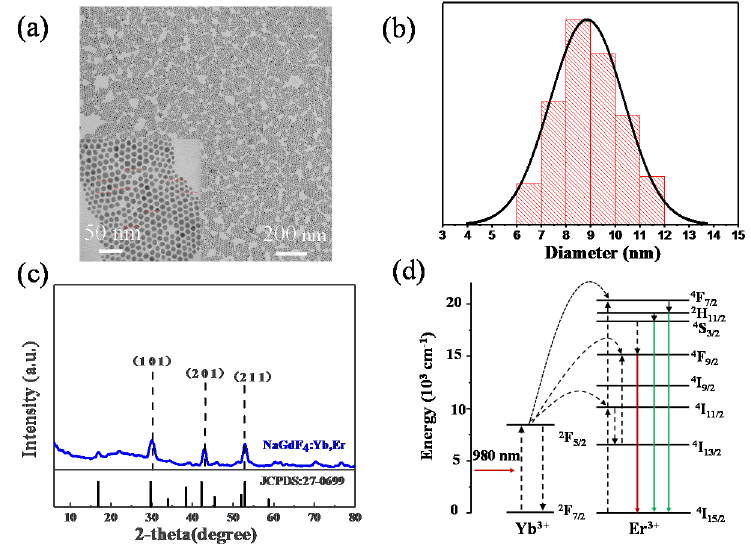
Figure 6. ( a ) TEM image of NaGdF 4 :Yb, Er nanoparticles; ( b ) corresponding diameter distribution histogram; ( c ) XRD pattern of NaGdF 4 :Yb, Er; ( d ) the mechanism of up-conversion processes of NaGdF 4 :Yb, Er.